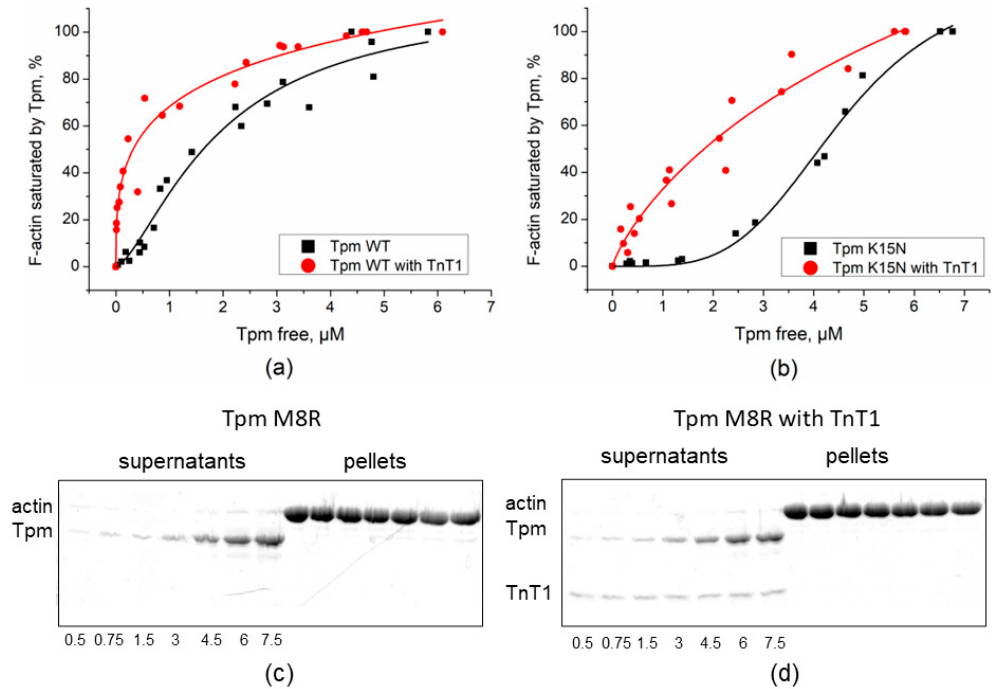
Figure 1. The affinity of the Tpm WT and N-terminal mutants Tpm M8R and K15N mutants to F-actin in the presence of TnT1. Results obtained by co-sedimentation assay are plotted as a fraction of F-actin saturated by Tpm against the concentration of free Tpm found in the supernatant. ( a , b ) The affinity of the Tpm WT and Tpm K15N. The assay was performed in buffer containing 200 mM NaCl. The estimated K 50% values were 1.61 ± 0.24 µM for Tpm WT alone and 0.3 ± 0.16 µM for Tpm WT in the presence of TnT1 ( a ) and 4.1 ± 0.01 µM for Tpm K15N alone and 1.8 ± 0.6 µM for Tpm K15N in presence of TnT1 ( b ). ( c , d ) SDS-PAGE of co-sedimentation assay of Tpm M8R alone ( c ) and in the presence of TnT1 ( d ) with F-actin. Total concentrations (µM) of Tpm in the samples are listed under gels.